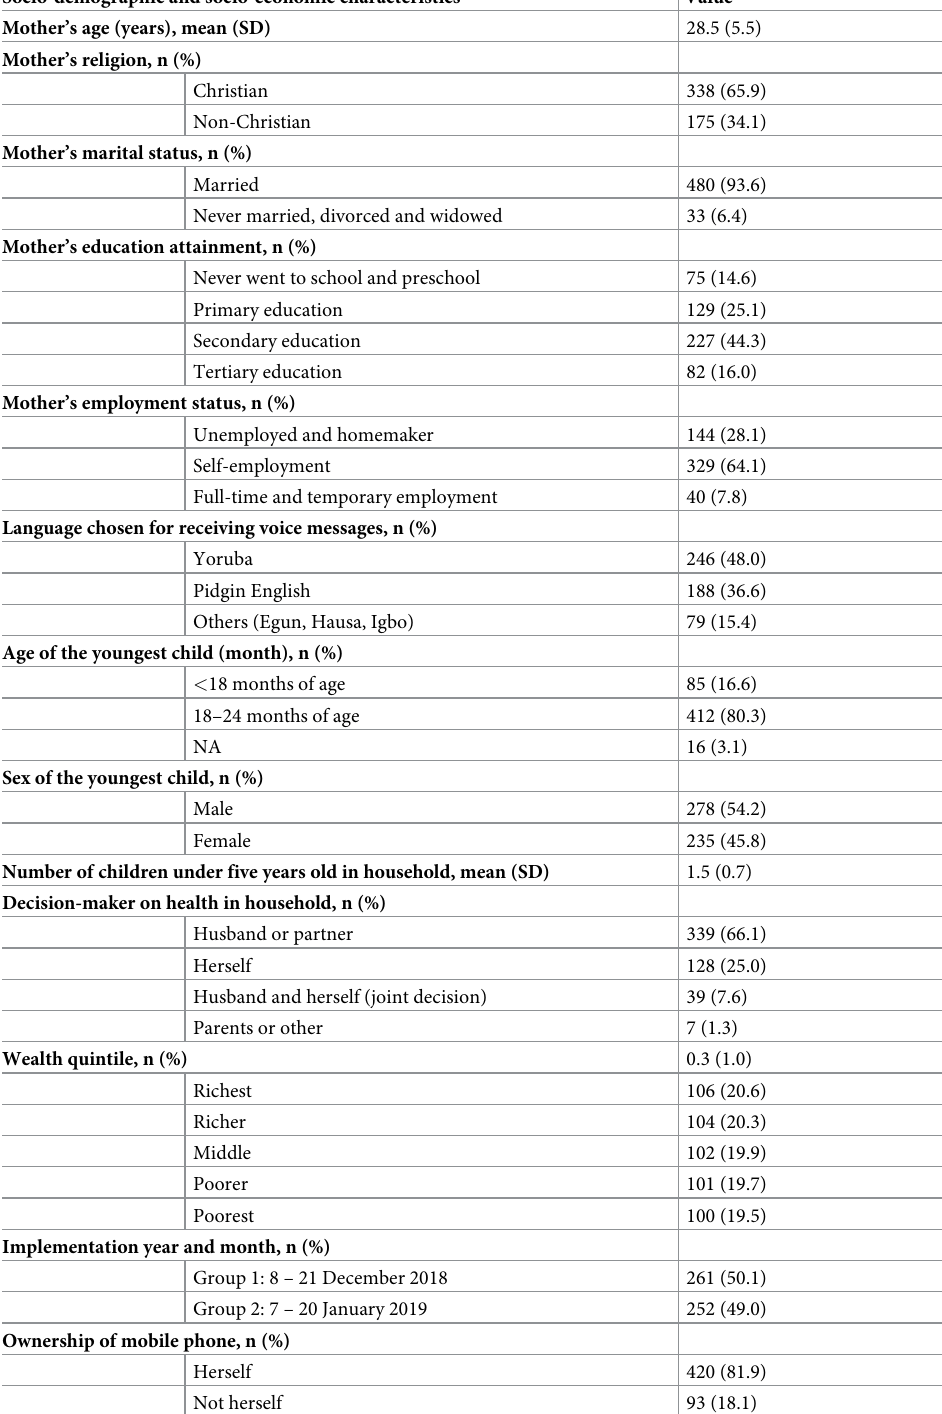
Table 2. Socio-demographic and socio-economic characteristics of study participants (n =